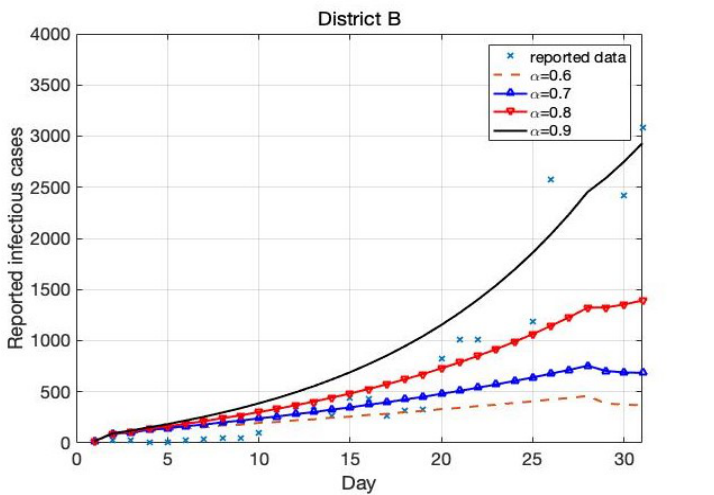
Figure 9. Model results for infected cases.